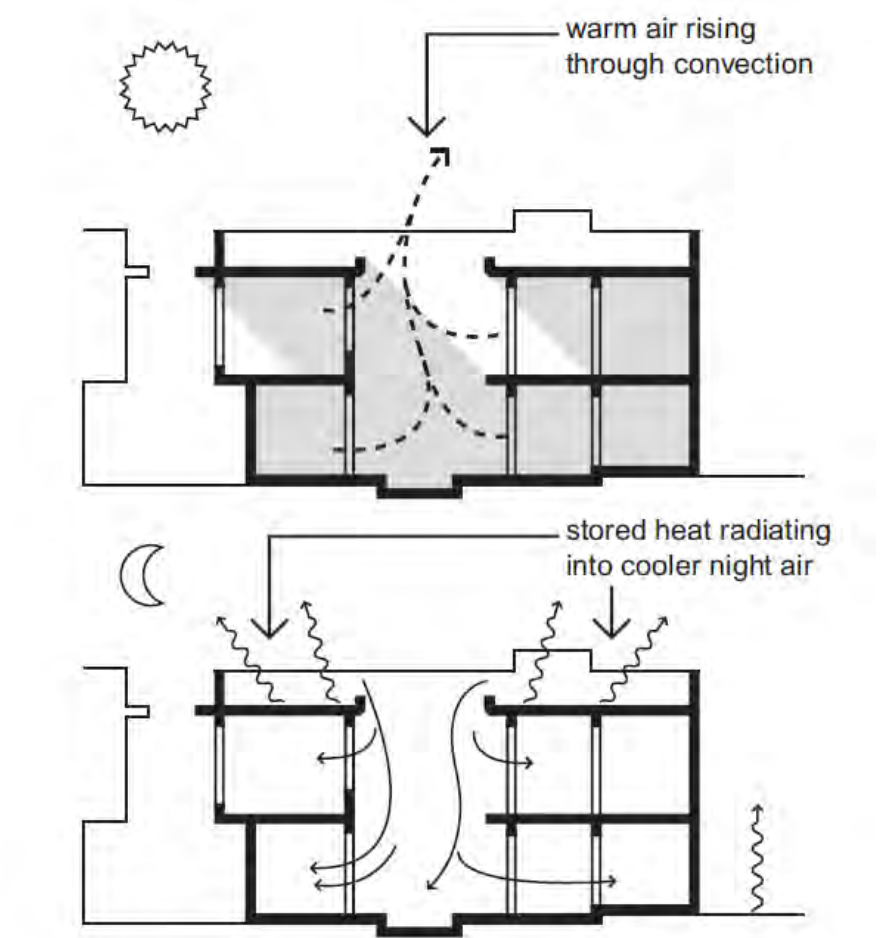
Figure 5. Courtyards(St.Clair,2009)